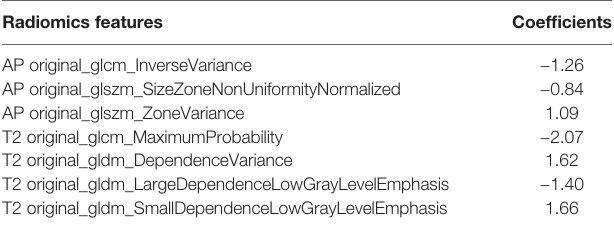
TABLE 5 | Selected features in T2WI-AP radiomics model in VOI interface and corresponding coef fi cients. Radiomics